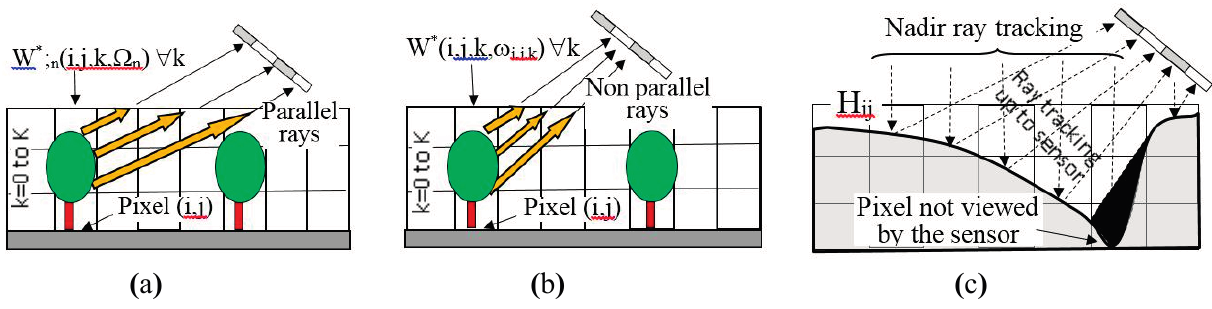
Figure 17. Schematic representation of the DART procedure that simulates orthorectified RS images: an ideal orthorectification with orthographic ( a ) and perspective projection ( b ), respectively, and an industry orthorectification ( c ) with either perspective or orthographic projection.